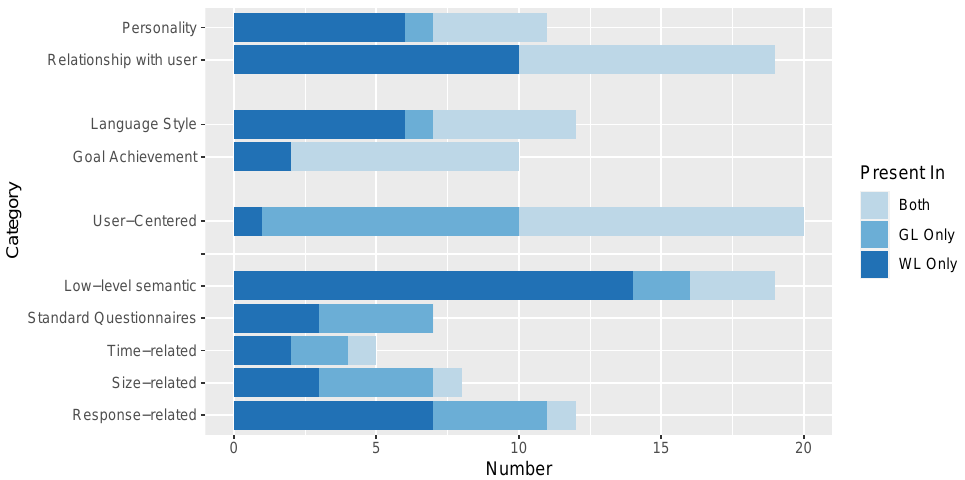
Figure 14. Exclusive and common quality attributes for typology of source, grouped by attribute cat-